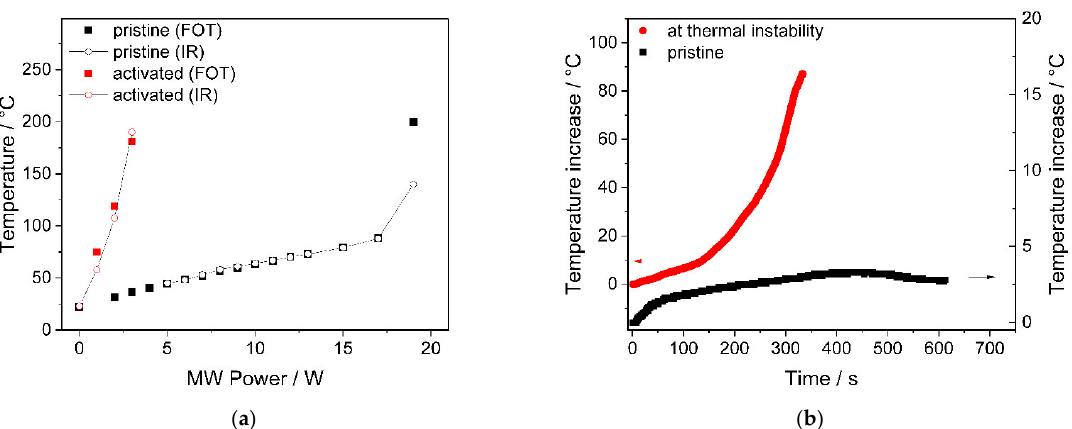
Figure 4. ( a ) Heating behavior of an LSC-82 catalyst under MW-radiation before and after a sustained activation treatment under thermal instability conditions. ( b ) Normalized FOT-temperature response vs. time to an incremental 1 W power increase before (black arrow, right y ‐ axis) and at the thermal instability region (red arrow, left y ‐ axis). The measurement at thermal instability region had to be stopped to avoid damage to the sensor.